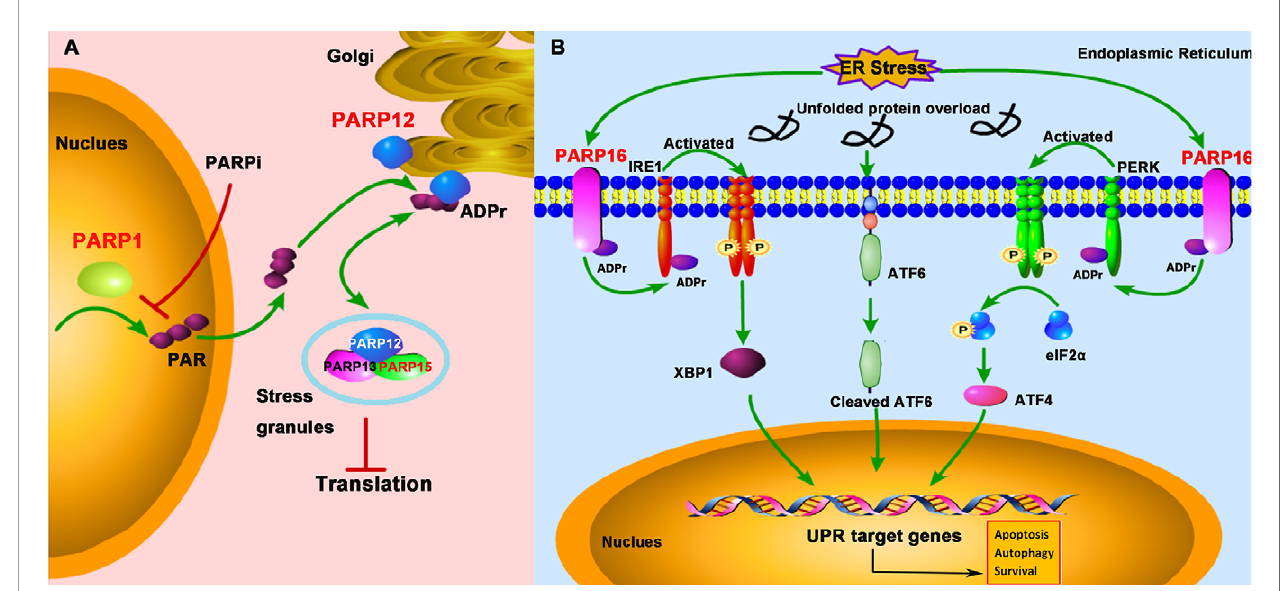
FIGURE 4 | PARPs regulate the cellular stress-mediated innate immune responses. (A) PARP1 catalyzes the formation and release of poly-ADP-ribose (PAR) from the nucleus; subsequently, PAR binds to PARP12 and promotes its translocation from the Golgi to stress granule (SG), where PARP12, PARP13, and PARP15 form a complex to block the protein translation. The treatment of PARPi against PARP1 prevents PAR formation and PARP12 translocation from the Golgi to SG. (B) The unfolded protein response (UPR) activation is initiated by three ER (endoplasmic reticulum)-localized integral membrane proteins, PKR-like endoplasmic reticulum kinase (PERK), Activating Transcription Factor 6 (ATF6), and Inositol-Requiring Enzyme 1 (IRE1). PARP16 localizes in the ER and is upregulated during ER stress, which subsequently promotes the mono-ADP-ribosylation (ADPr) of IRE1 and PERK. ADP-ribosylated IRE1 and PERK are activated by phosphorylation and form dimers in the